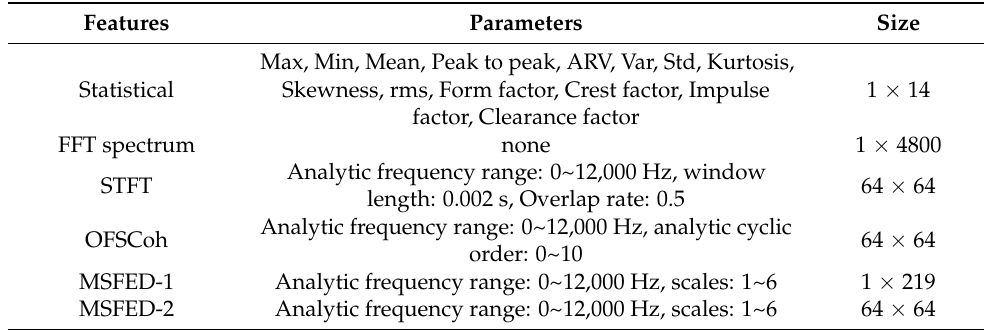
Table 2. The parameter value used in features